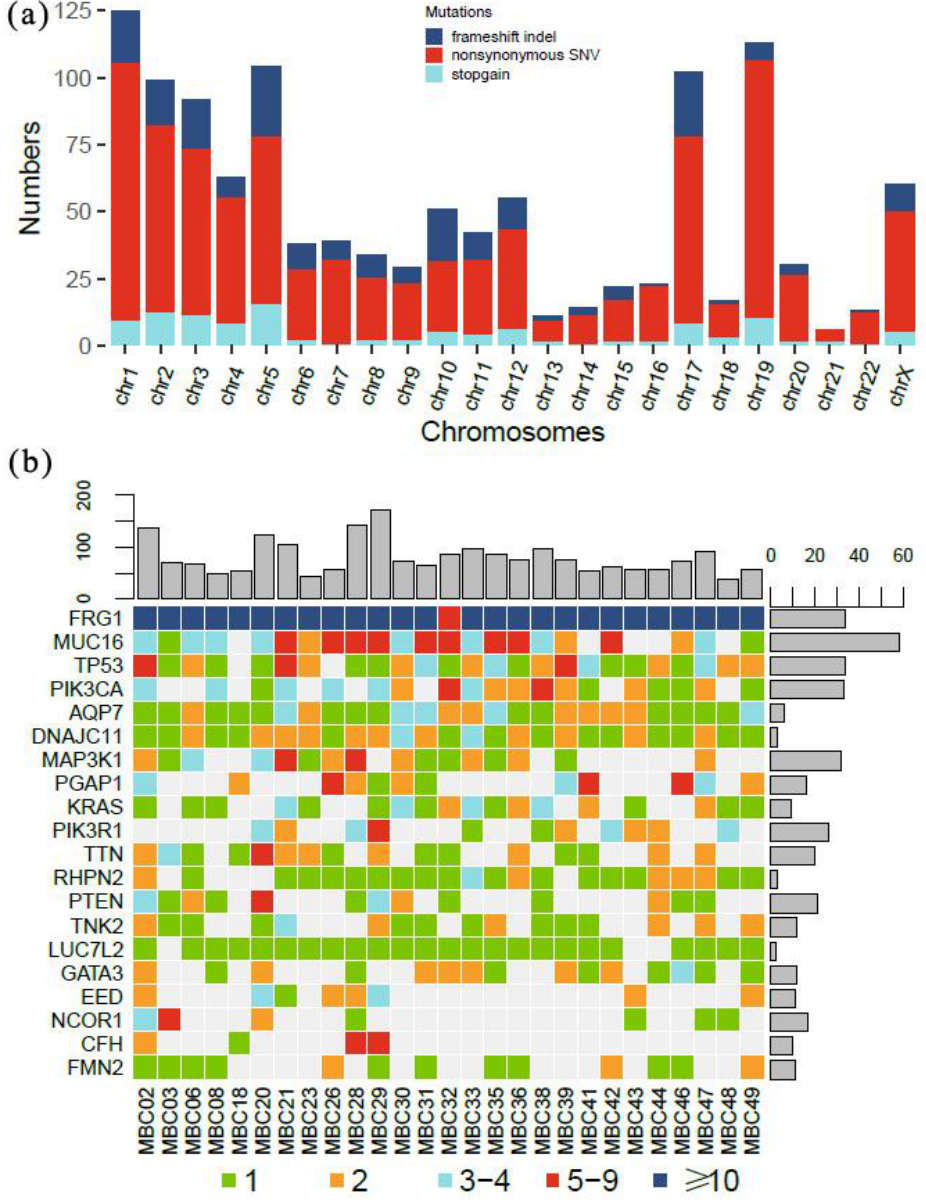
Figure 1. Profiles of ctDNA mutations identified. ( a ) Distribution of ctDNA mutations on all chromosomes. Height of each column represents number of mutations. ( b ) Mutation burden of ctDNA in top 20 genes for 27 MBC patients. Number of mutations in each gene and patients are listed right and top, respectively.